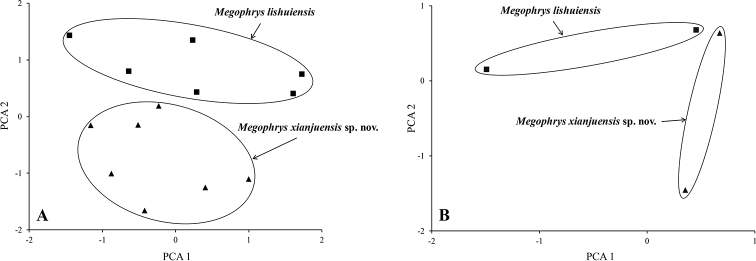
Plots of the first principal component (PC1) versus the second (PC2) for Megophrys
xianjuensis sp. nov. and M.
lishuiensis from principal component analyses A male B female.